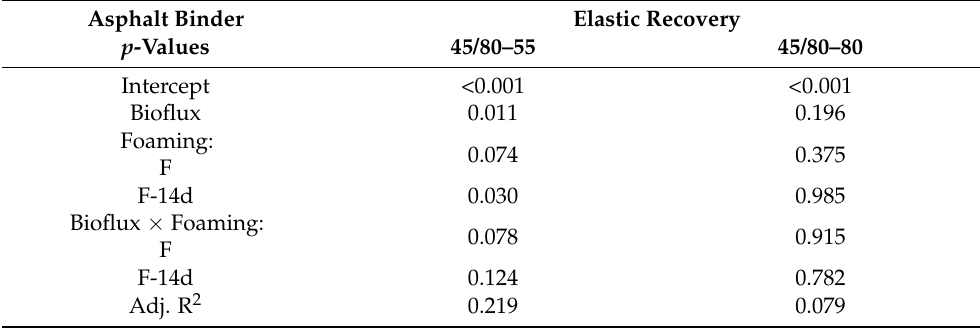
Table 4. The p -values calculated in analyses of variance for assessing the significance of the effects of Bioflux and foaming on the elastic recovery of asphalt